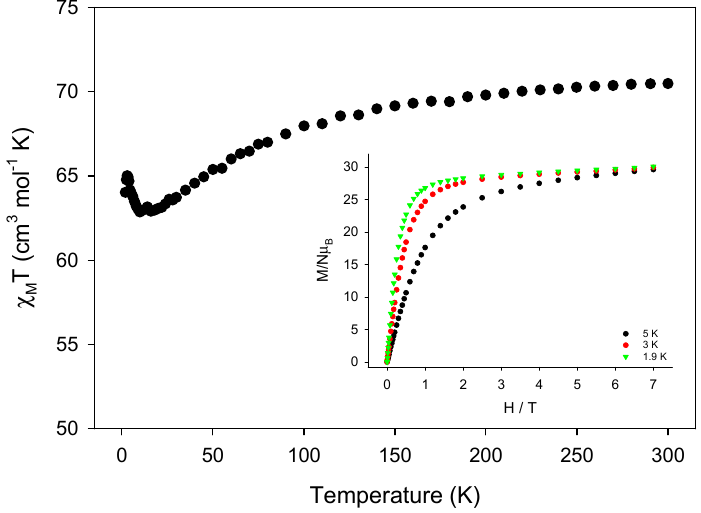
Figure 4. Temperature dependence of the χ Μ T product for complex 1 ∙ 3MeOH ∙ CH 2 Cl 2 at 0.1 T. (inset) Plots of magnetization ( M ) versus field ( H ) for complex 1 ∙ 3MeOH ∙ CH 2 Cl 2 at three different low temperatures.